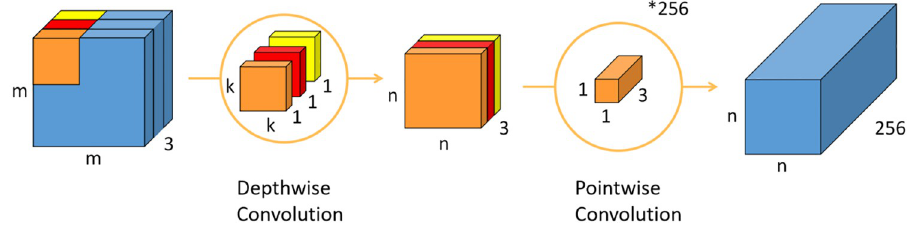
Fig 1. Schematic of depthwise revolution and pointwise